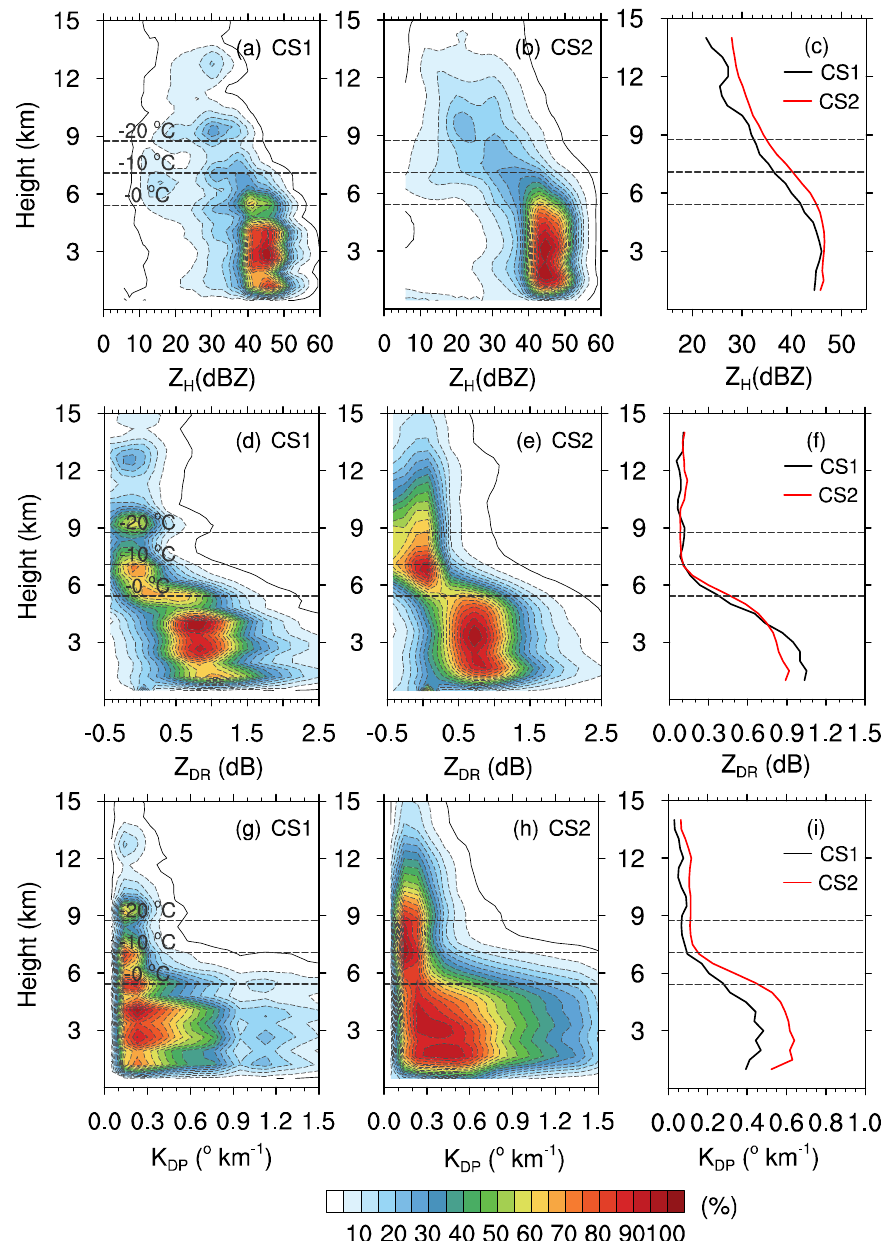
Figure 8. The CFADs(unit: %) of ( a , b ) Z, ( d , e ) Z DR , and ( g , f ) K DP for the CS1 CCs (first column), and for the CS2 CCs (second column).Contours and shadings represent the frequency of occurrence relative to the maximum absolute frequency in the data sample represented in the CFAD, contoured every 5%. ( c , f , i ) The percentile profiles of Z, Z DR , and K DP for the CS1 CCs (black solid lines)and CS2 CCs (red solid lines).The black dashed lines represent the level of 0 °C, − 10 °C, and − 20 °C from bottom to top, respectively. The CS1analysis period is from 2124 LST on 31 May 2021 to 2254 LST on 31 May 2021. The CS2analysis period is from 2348 LST on 31 May 2021 to 0800 LST on 1 June 2021.